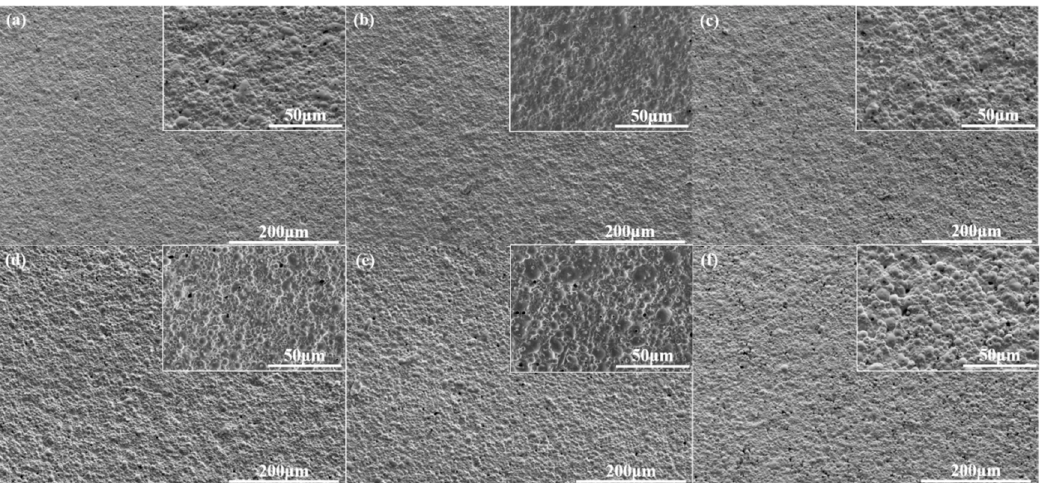
Figure 6. The particle sizes of WPU-R dispersions and gloss of WPU-R films with different R values.